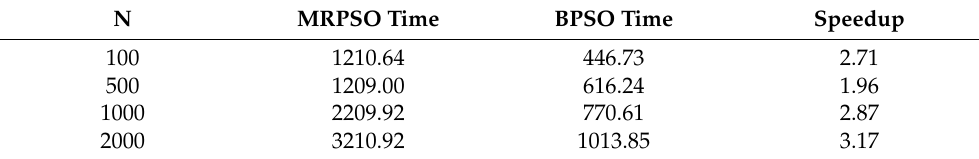
Table 4. MRPSO and BPSO running time and speedup on f 3 .